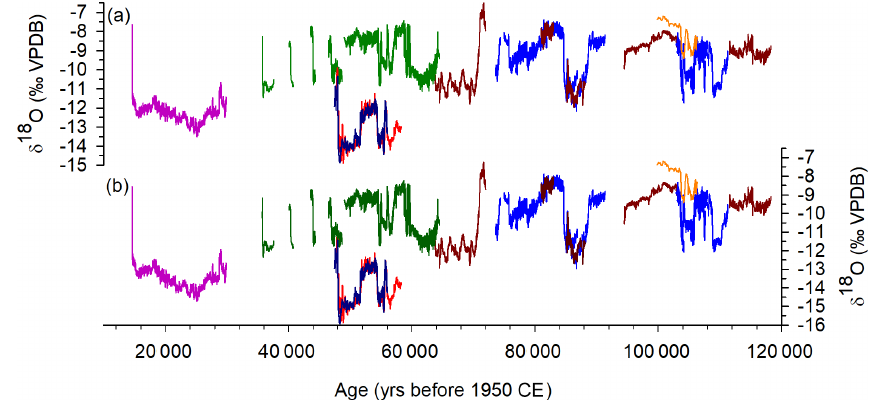
Figure 6. Speleothem δ 18 O records from the northern rim and central European Alps. (a) Original records: pink (Luetscher et al., 2015), green (Moseley et al., 2014), red and dark blue (Spötl et al., 2006), dark red (Boch et al., 2011, contained in NALPS19), medium blue (new record in this study), and orange (see Fig. S9). (b) δ 18 O records corrected for δ 18 O variability as a result of changing ice volume. Colour coding the same as in (a)